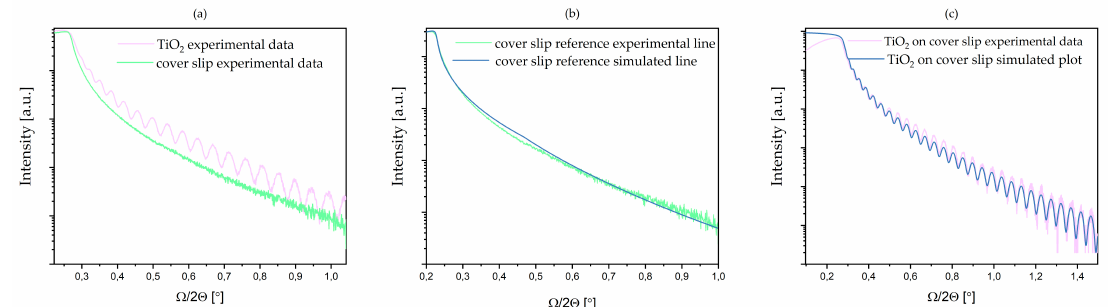
Figure 2. The XRR data plots of TiO 2 obtained by ALD on a glass substrate (green colour) and uncoated coverslip (magenta colour): ( a ) the experimental line; ( b ) the fitting line (blue colour): for the coverslip sample; ( c ) the fitting line for TiO 2 on the coverslip sample (fit simulation made using Parratt’s